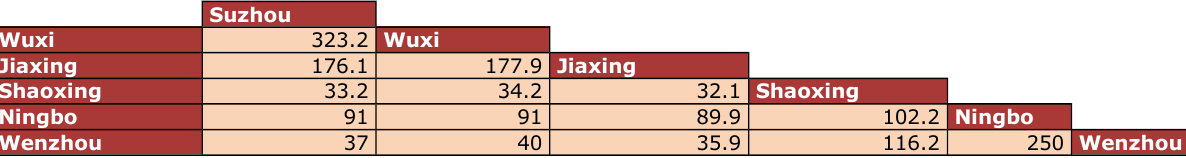
Table 3. The Distance of Saving in Same